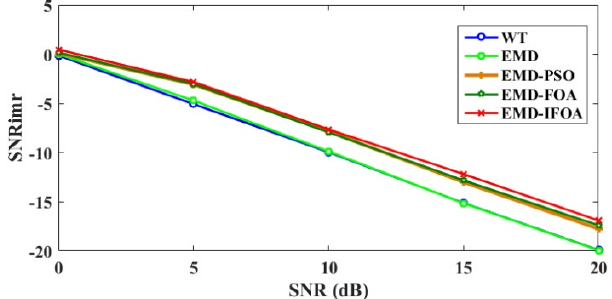
Figure 9. The SNR improvement of the five methods in different SNRs. SNR imr : signal-to-noise ratio improvement.